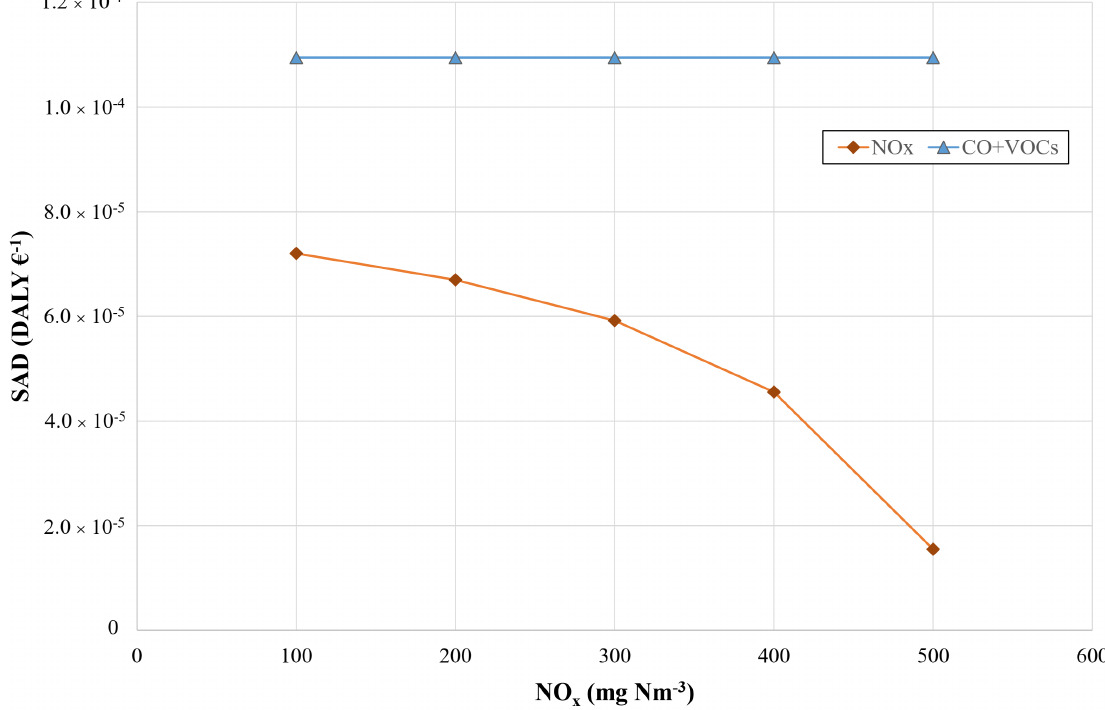
Figure 5. Trend of the SAD index (expressed in DALY e − 1 ) of the two devices as a function of the released NO x for the second